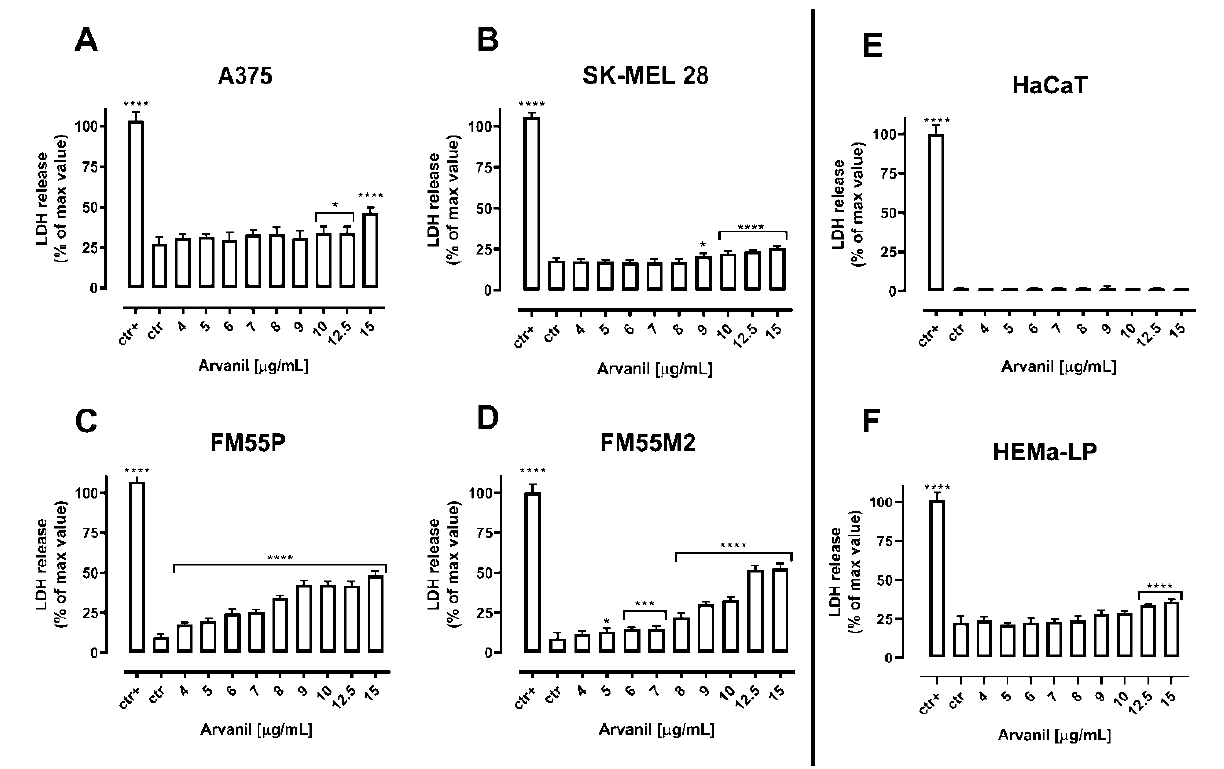
Figure 4. Cytotoxicity of arvanil to malignant melanoma cells [A375 ( A ), SK–MEL 28 ( B ), FM55P ( C ) and FM55M2 ( D )], normal human keratinocytes [HaCaT] ( E ), and normal human melanocytes [HEMa–LP] ( F ). Lactate dehydrogenase ELISA kit was used to quantify cytotoxicity by measuring LDH activity released from damaged cells. Normal keratinocyte cells and melanoma cells were in ‐ cubated for 72 h alone or in the presence of arvanil (4–15 μ g/mL). The results are presented as the percentage in LDH released to the medium by treated cells versus cells grown in control medium (ctr) and cells treated with lysis buffer (ctr+). Data are presented as mean ± SEM (* p < 0.05, *** p < 0.001, and **** p < 0.0001).